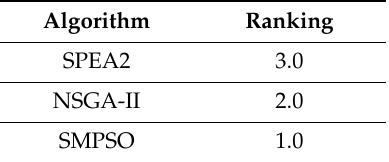
Table 5. Average ranking of the algorithms considering the I HV metric. Friedman statistic considering increasing performance (distributed according to χ 2 with 2 degrees of freedom: 6.0, p -value < 0.05).